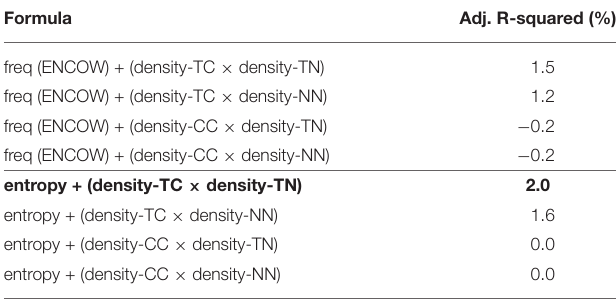
TABLE 5 | Comparison of model variants processing verb targets in the N-V-A space, and their explained variance (represented in terms of adjusted R-squared). Formula